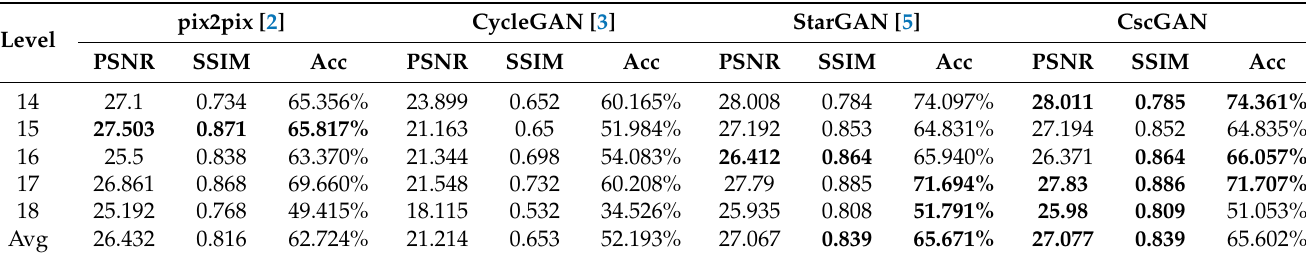
Table 4. The results of different methods evaluated on the RS-image-to-map dataset. Acc represents pixel accuracy, which is mentioned in Section 5.1.3. Avg represents the average result of the five levels. Note that the best results are highlighted in bold.